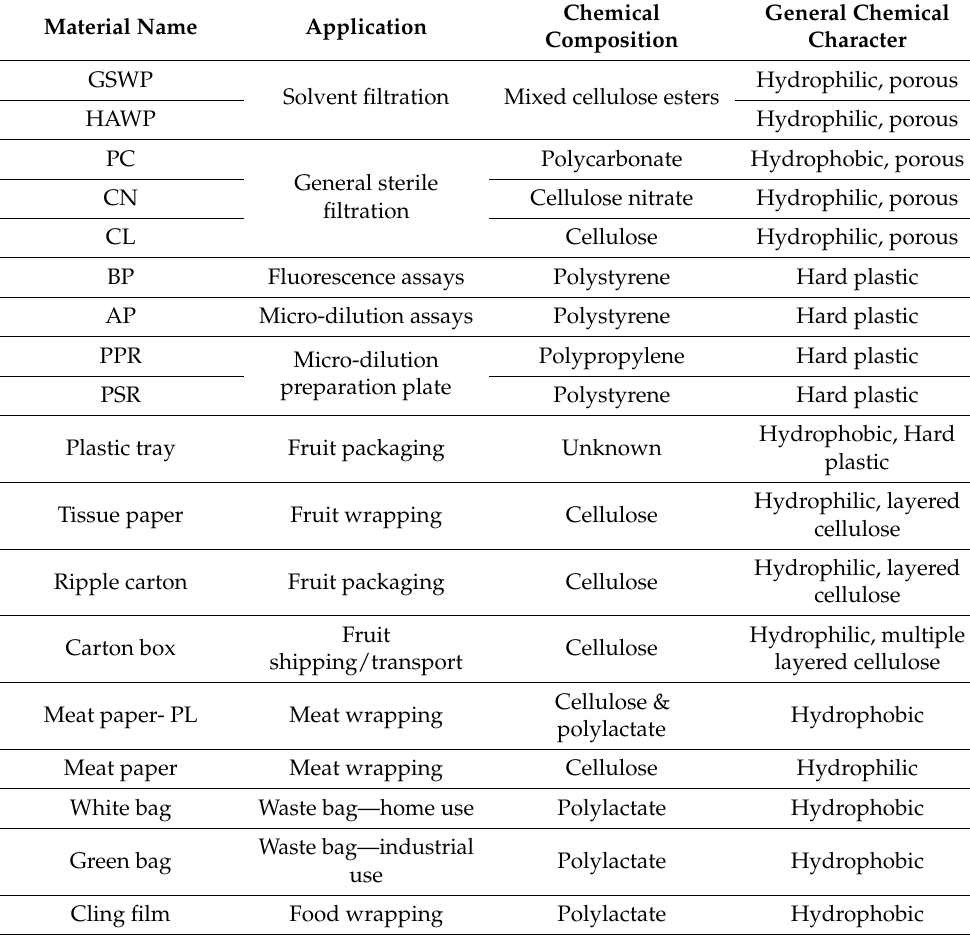
Table 1. Summary of the materials used in this study as base